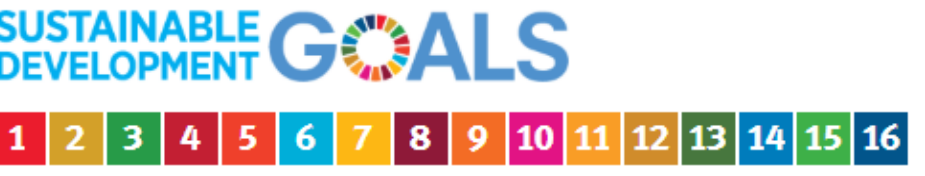
Source: ISO (2020, July).